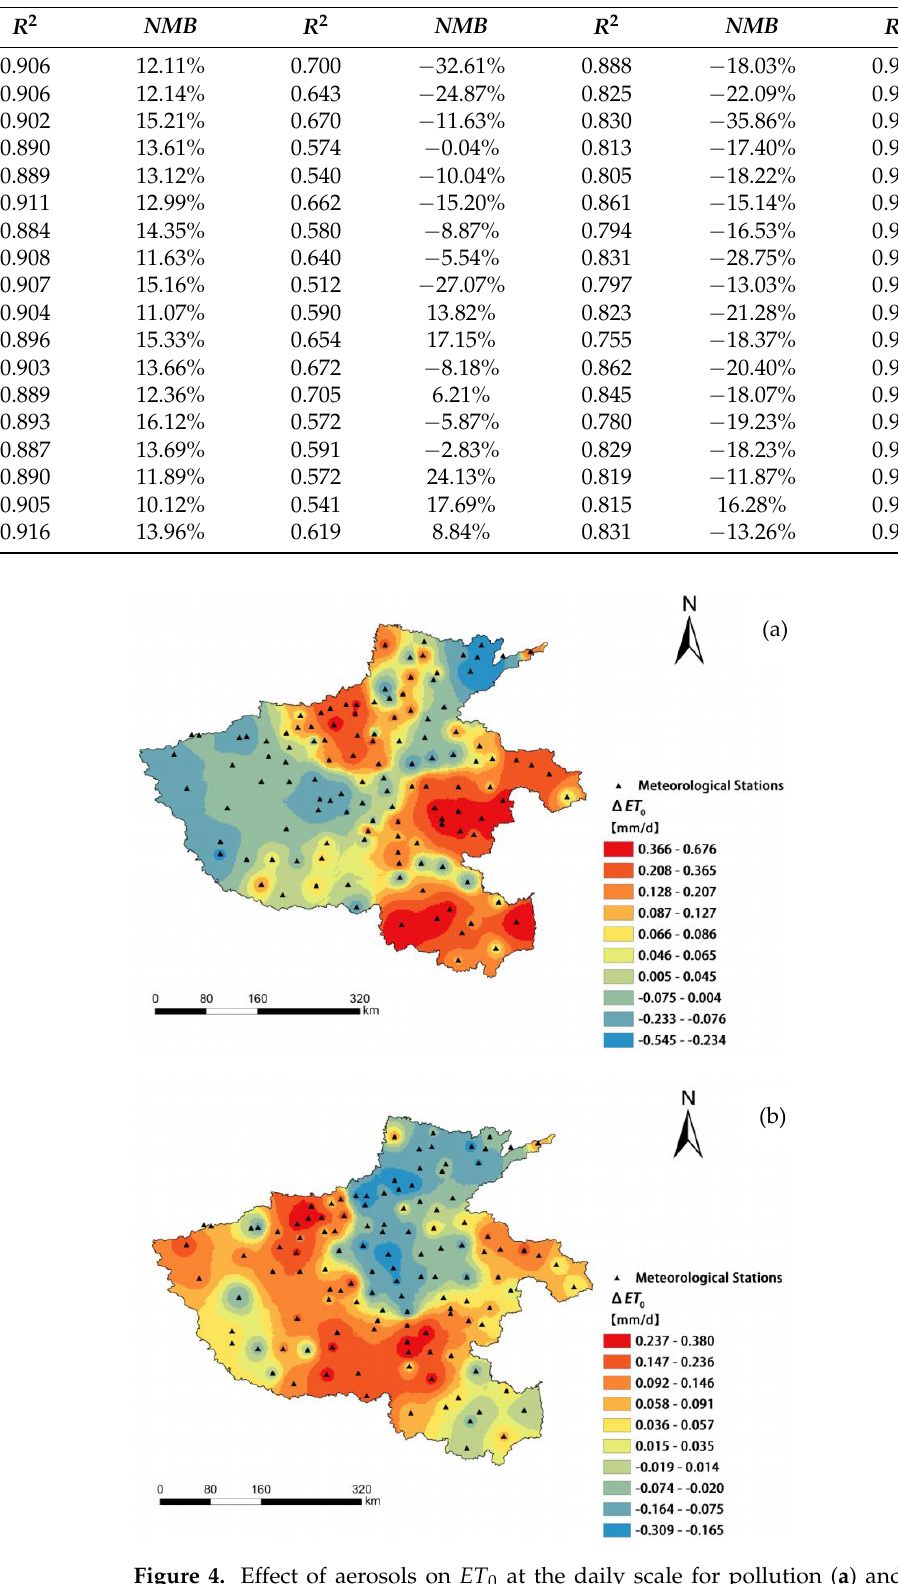
Figure 4. Effect of aerosols on ET 0 at the daily scale for pollution ( a ) and good ( b ) air quality condi- tions.